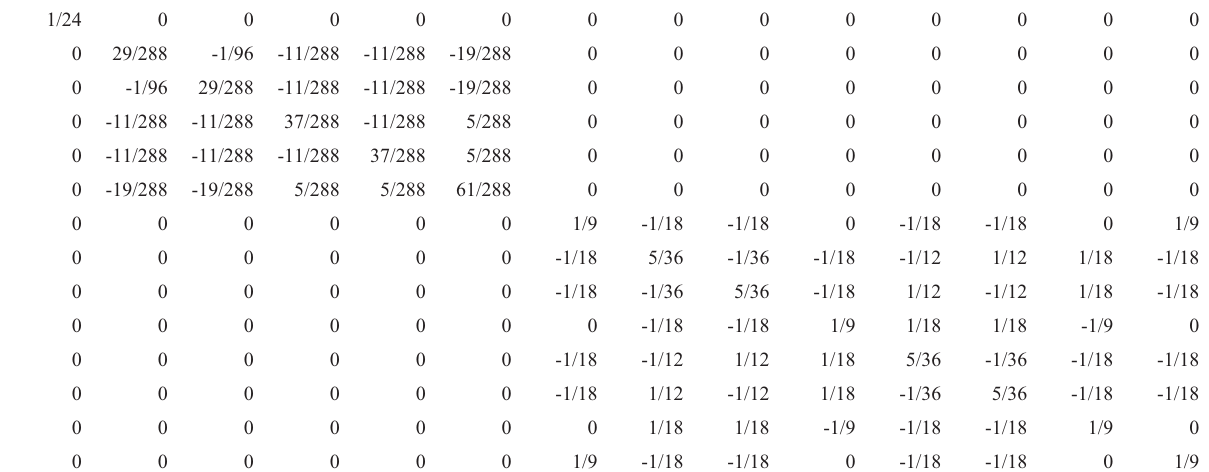
Table 15 - Estimates of the variances and covariances of the effects for an incomplete diallel model (Case 3, type 2 constraints) calculated using a matrix